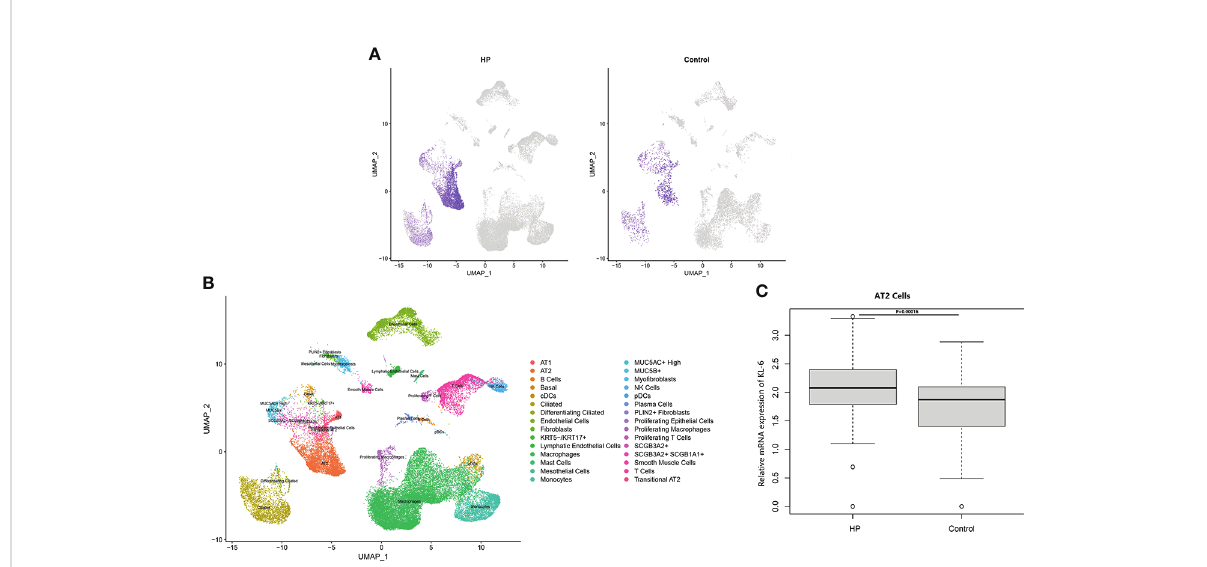
FIGURE 5 The scRNA-seq analysis in the GSE135893 (HP =3, control=8). (A) Feature plot of KL-6 in HP patients and controls. (B) Cell type annotation. (C) The different expressive analysis of KL-6 between HP and controls in AT2